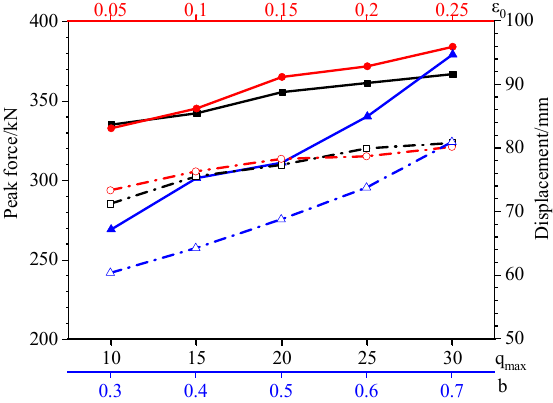
Figure 25. Peak forces and deformations under different parameters.